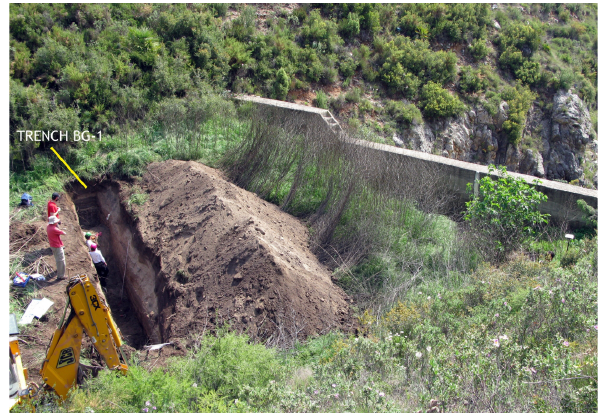
Fig. 5. The reservoir trench BG-1, closest to the “main check